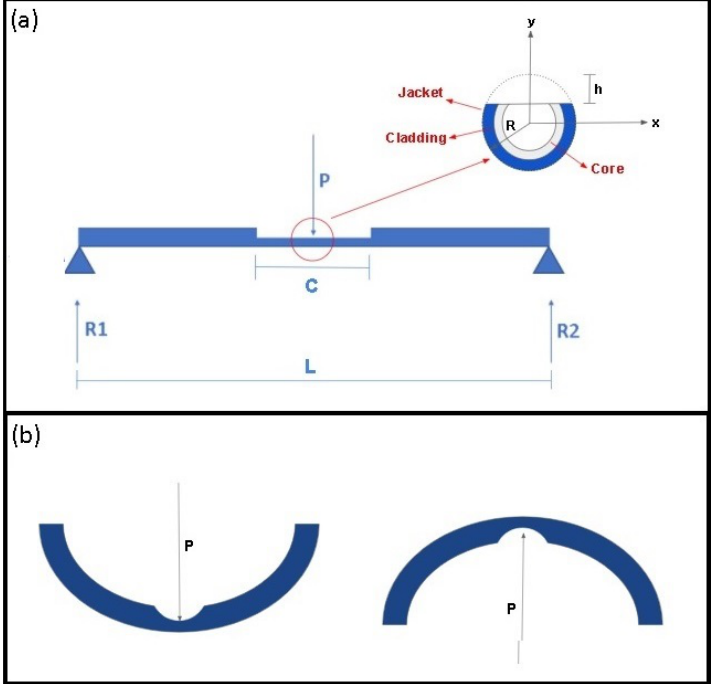
Figure 1. Optical fiber bending configurations. ( a ) Dimensional parameters of a simply supported optical fiber. Figure inset presents the cross-sectional view of the lateral section on the fiber’s top side. ( b ) The bending behavior of optical fiber in different